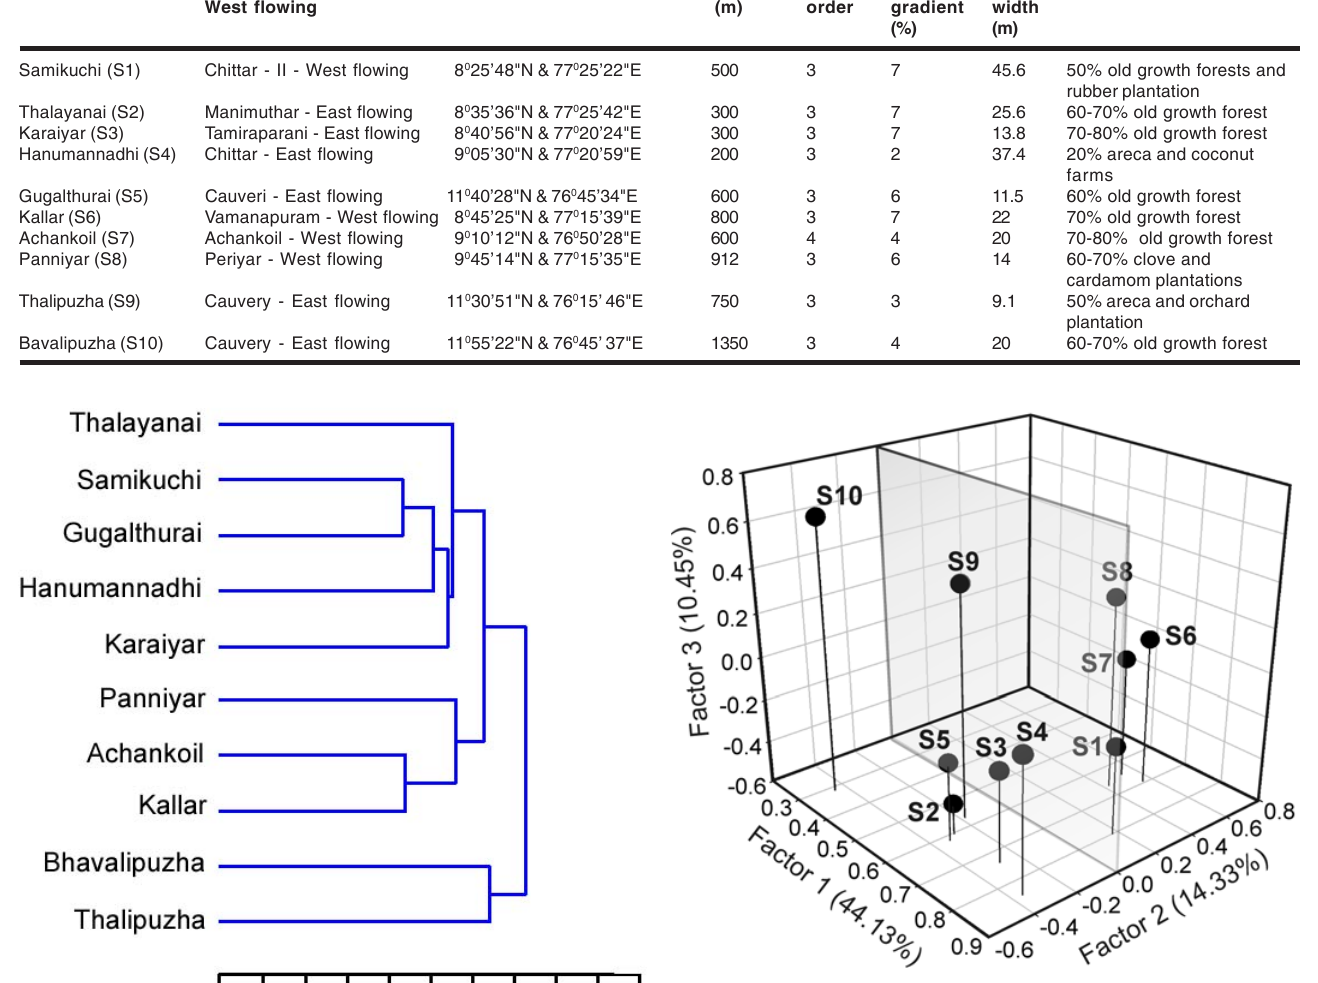
Figure 3. Principal Component Analysis (PCA) of streams based on freshwater fish species assemblage. Only first three significant factors with eigenvalue more than one are plotted. East flowing streams (S2, S3, S4, S5, S9 and S10) separate from the west flowing streams (S1, S6, S7 and S8) on the F2 axis (separated by a grey transparent plane). Numbers in parenthesis are percent variation explained by each PCA factor. Stream numbers are as per Fig.